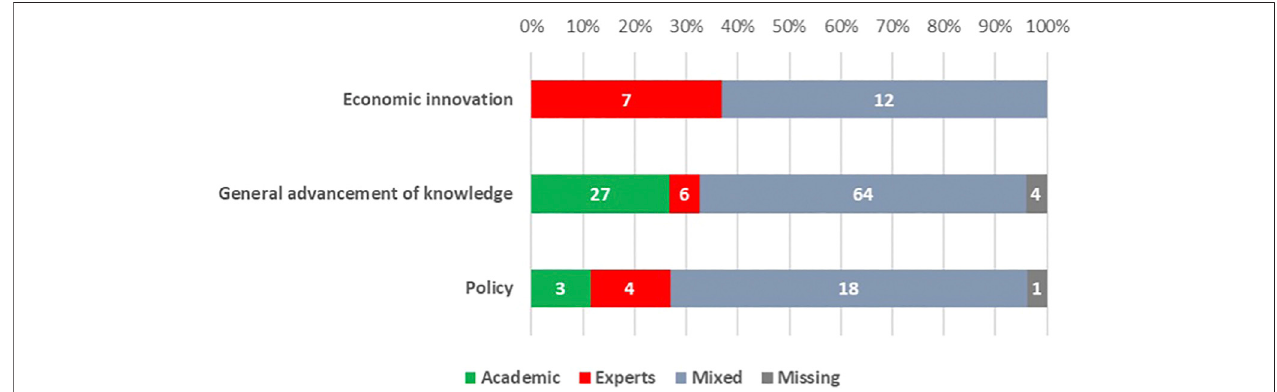
FIGURE 2 | Type of decision-making body by formal orientation of the instrument. (a.v. of single funding instruments).